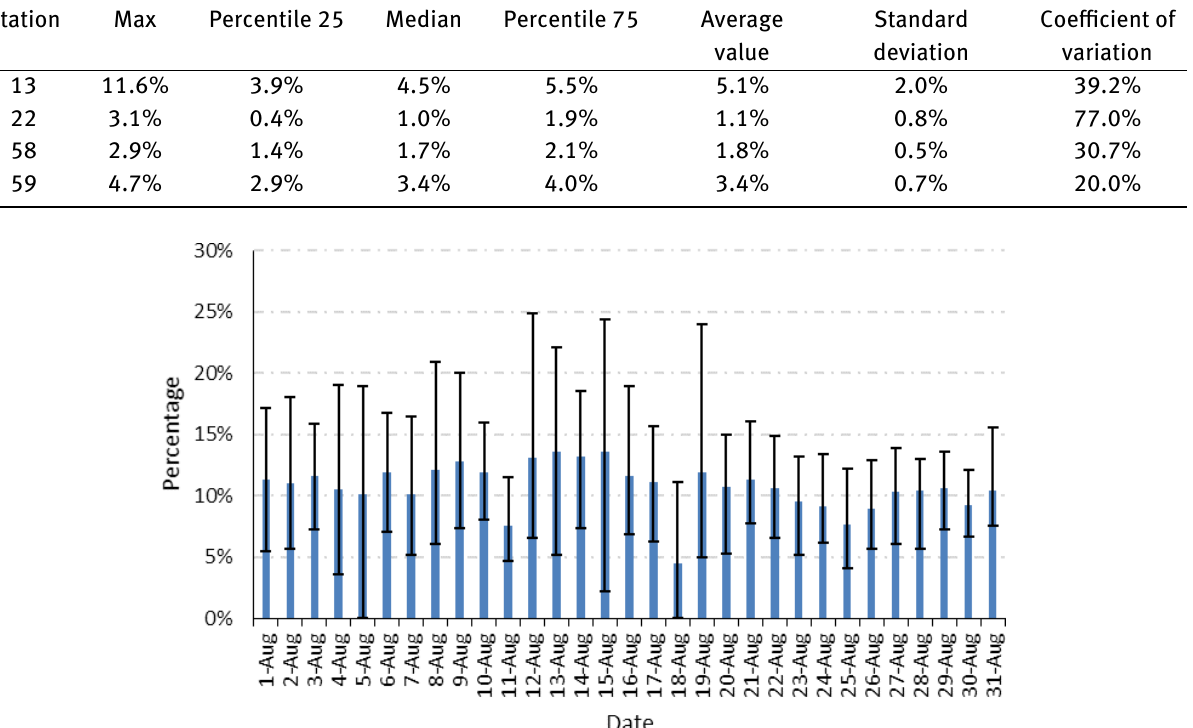
Figure 3: Shares of overloaded category 9 vehicles due to the gross weight, averaged for all stations, on particular measurement days (whiskers represent the minimum and maximum